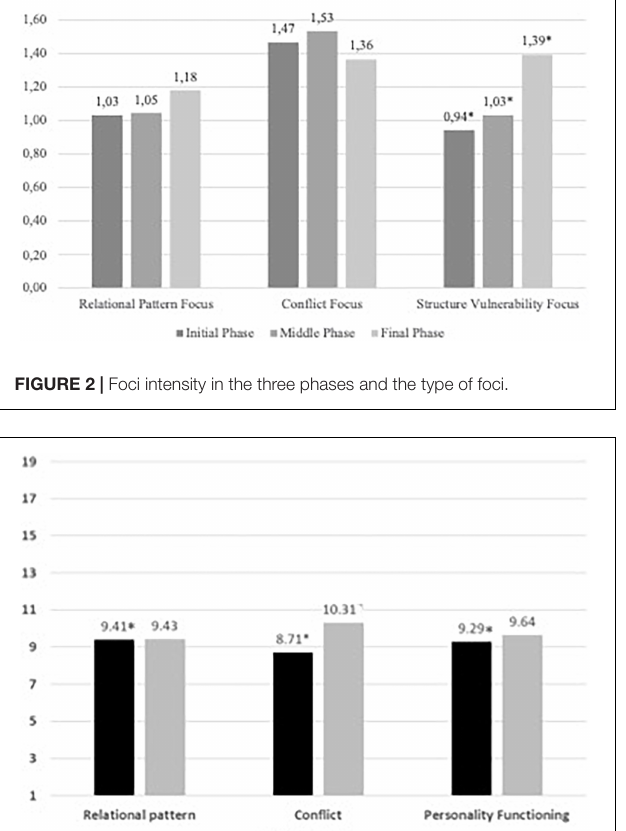
Foci Presence and Depth and